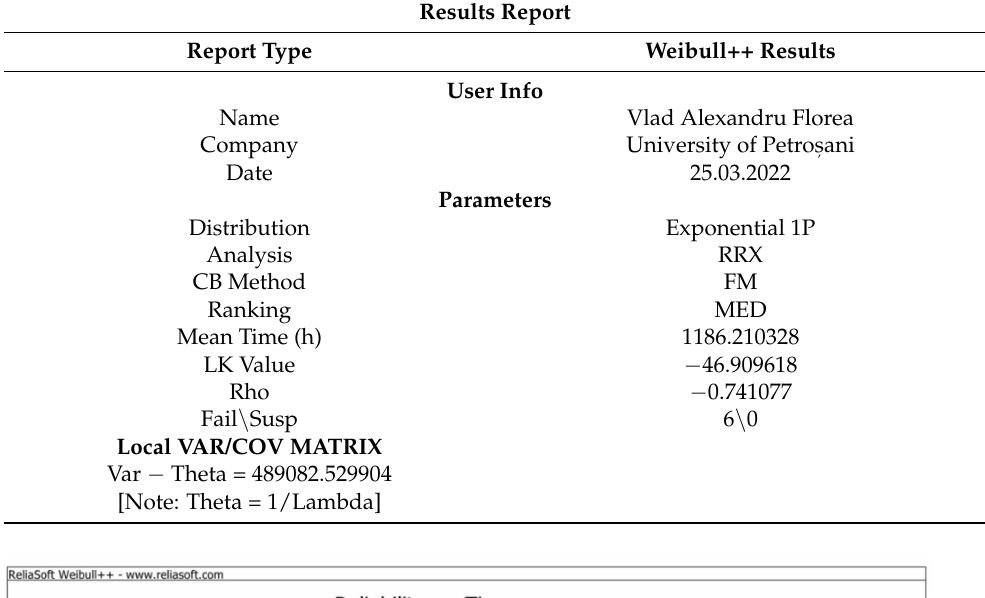
Table 9. Adopted exponential repartition law parameters for the cutter drum.